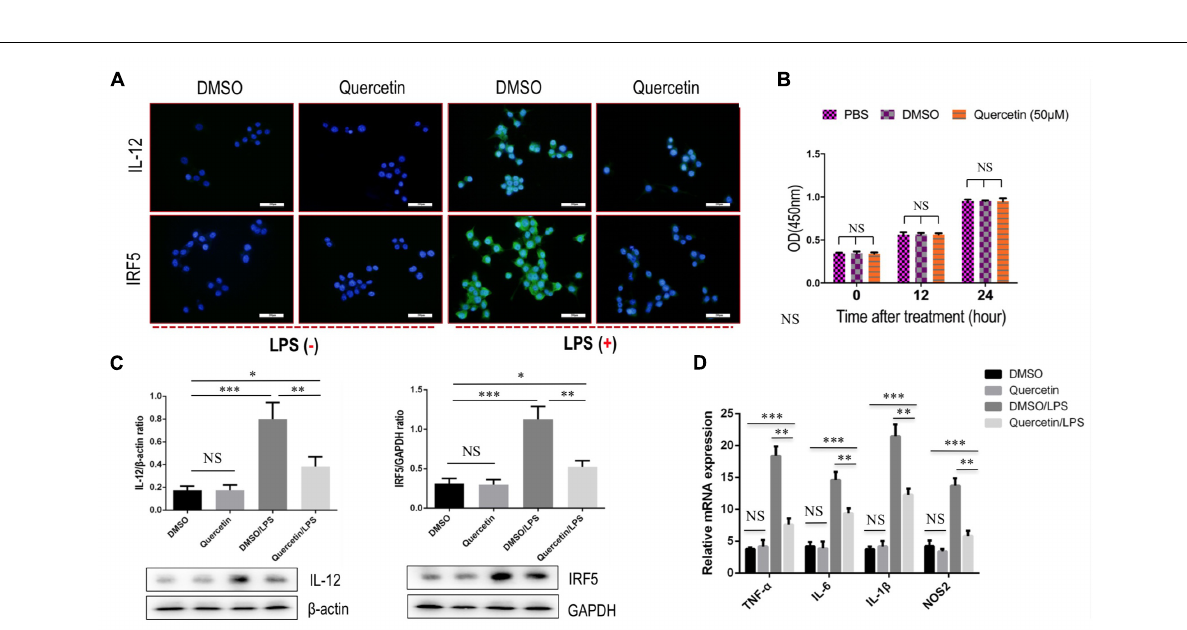
Frontiers in Pharmacology |